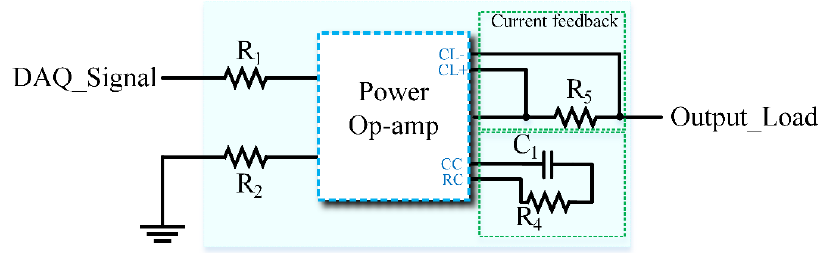
Figure 8. Power op-amp (Apex PA-05) used to perturb the supercapacitor.